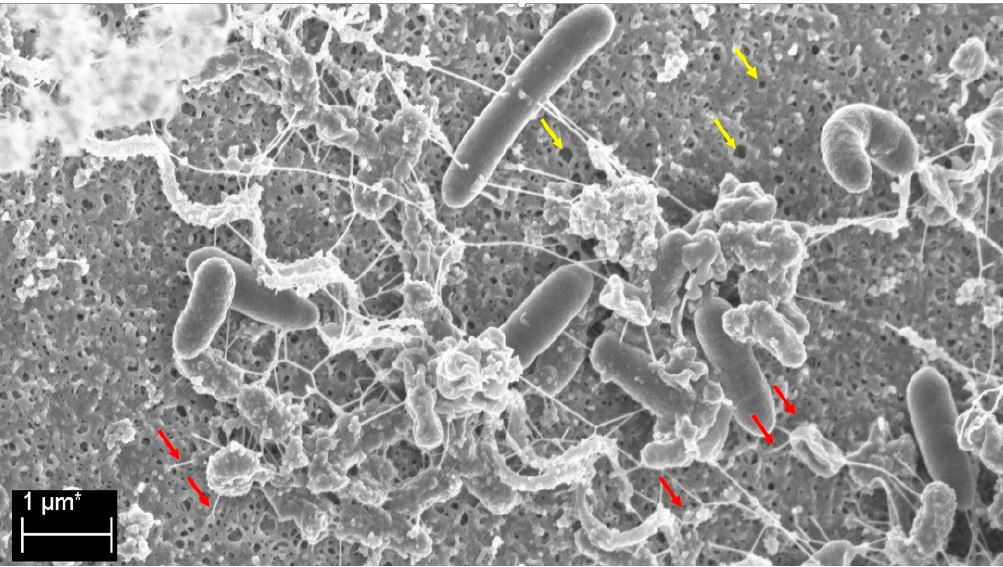
Figure 6. Cells of P. aeruginosa attached to agar surface (magnification 5000x). Yellow arrows indicate pores within agar facilitating the adhesion process; red arrows indicate the cells’ adhesive structures anchored to the pores in the agar. SEM Zeiss Auriga 60.